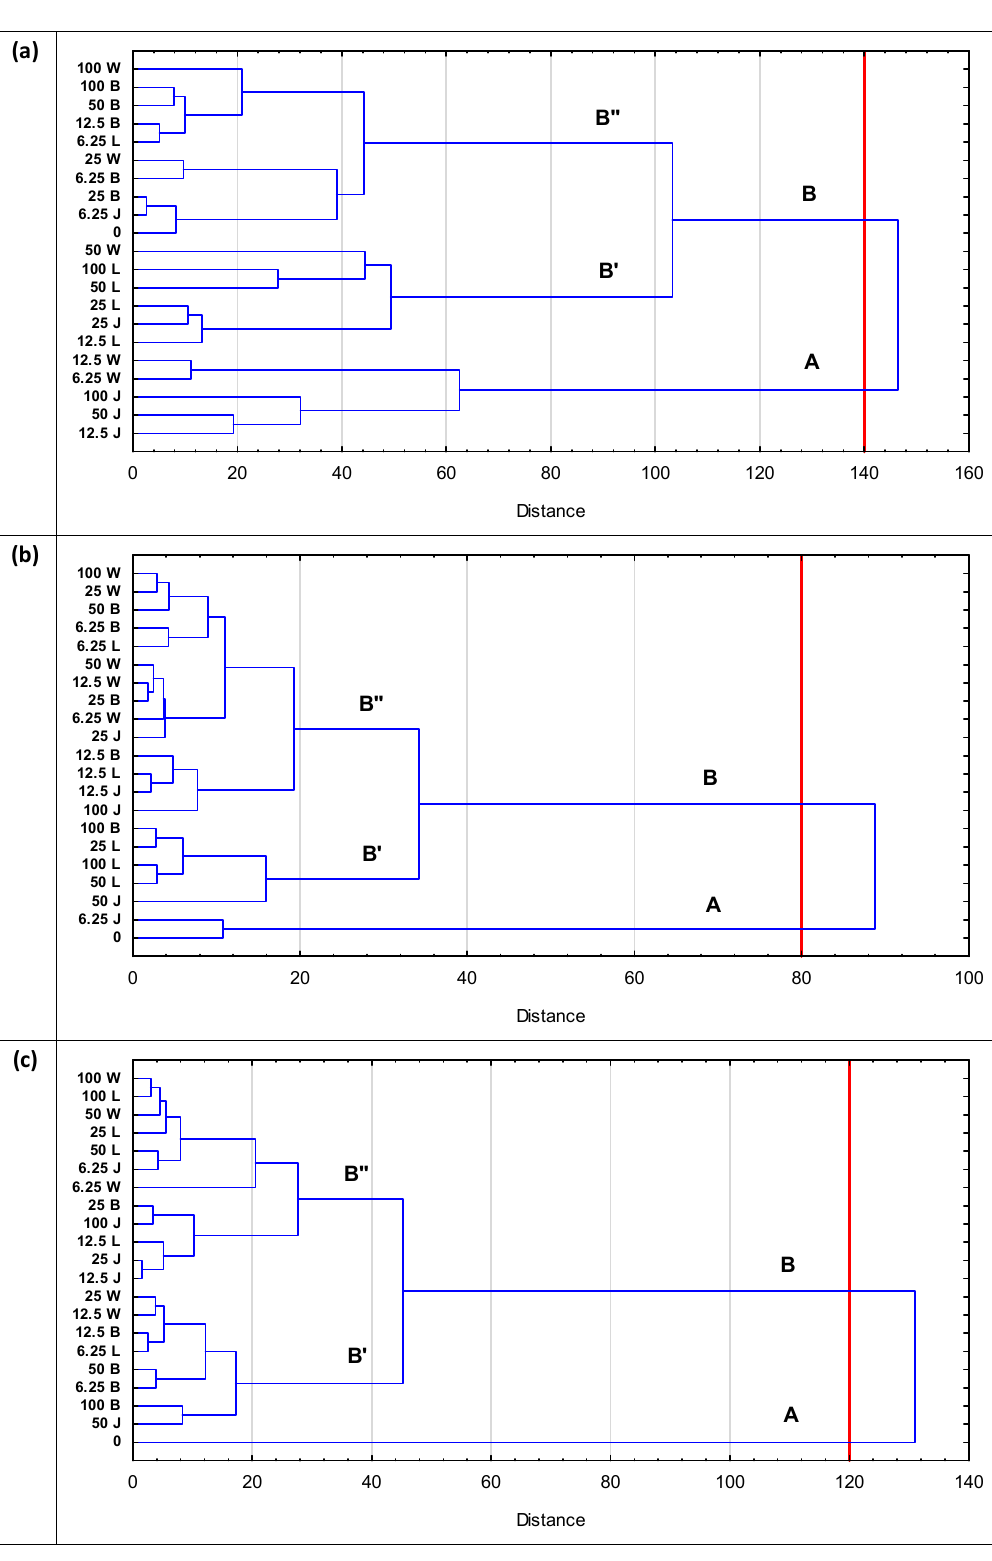
Figure 5. Dendrogram showing the similarities between the analysed samples: ( a ) Ceratophyllum demersum , ( b ) Phragmites australis —roots, and ( c ) Phragmites australis —shoots. Agglomeration was carried out using Ward’s method.